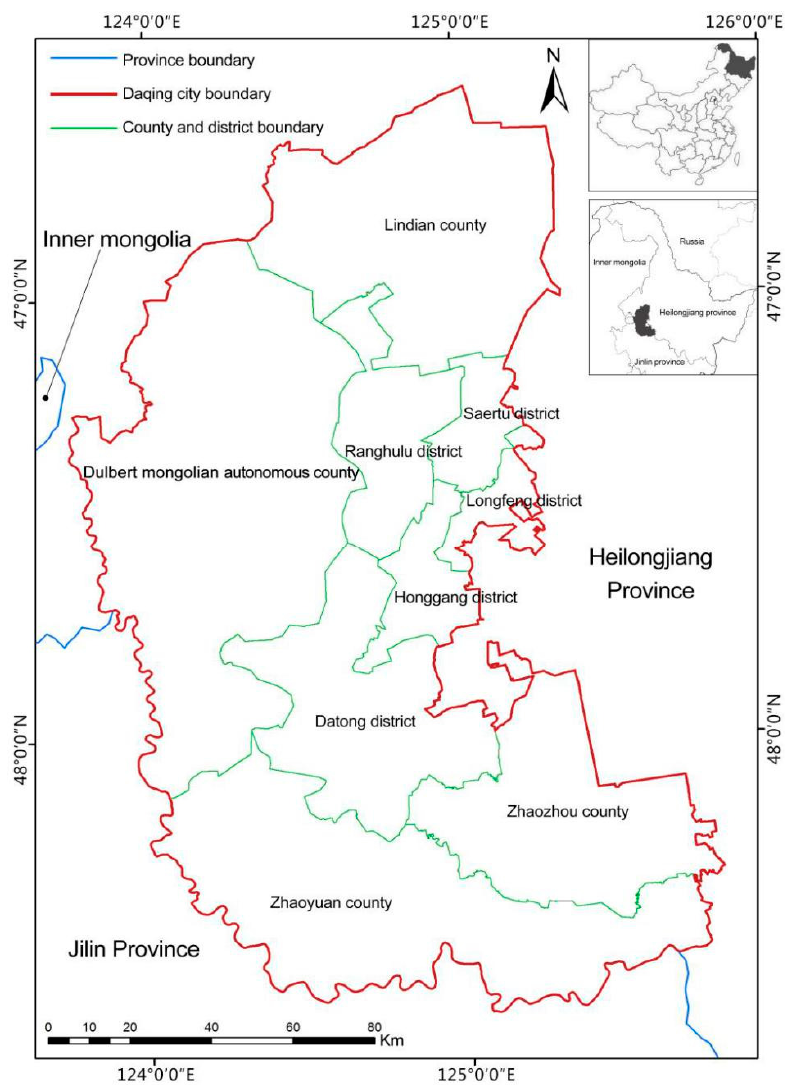
Figure 1. Geographical location of the study area.